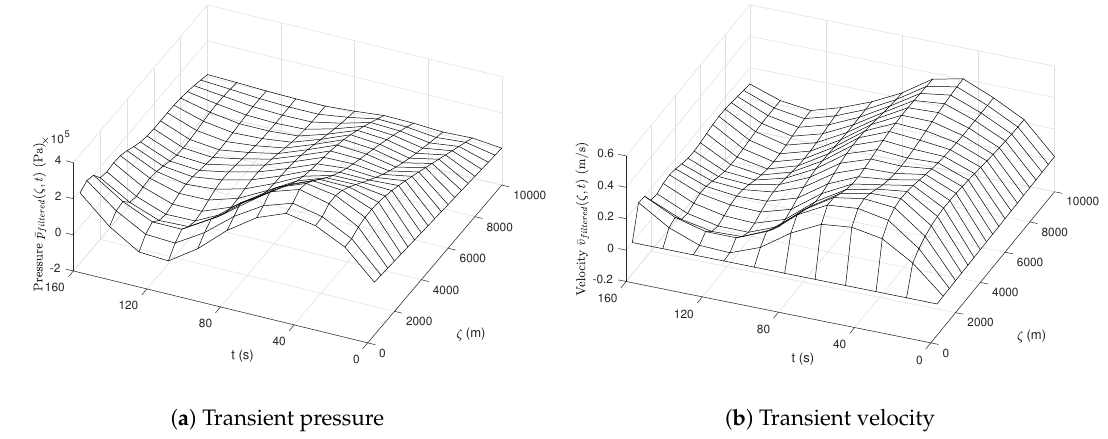
Figure 5. State evolution of the filtered water hammer system.